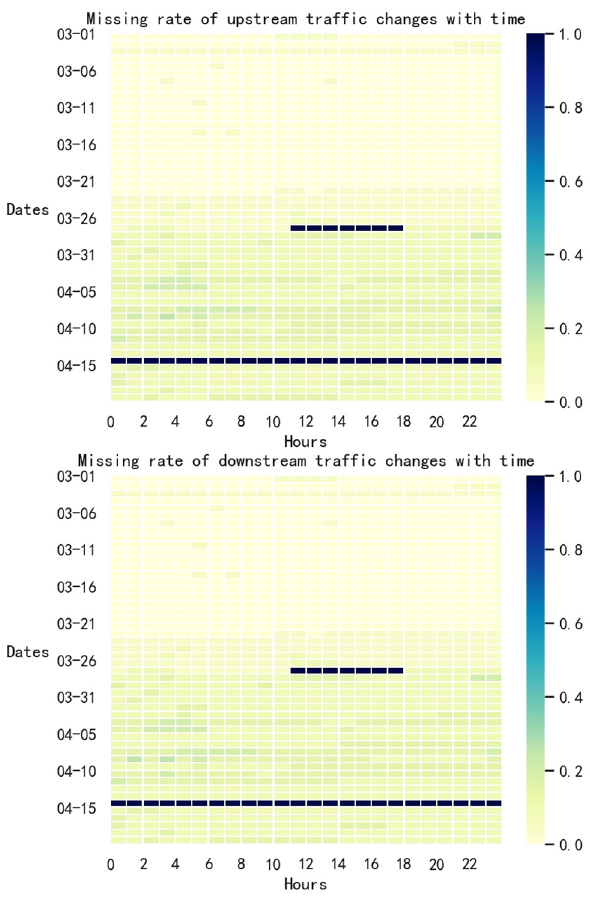
Fig. 2 Time variation of upstream and downstream traffic loss